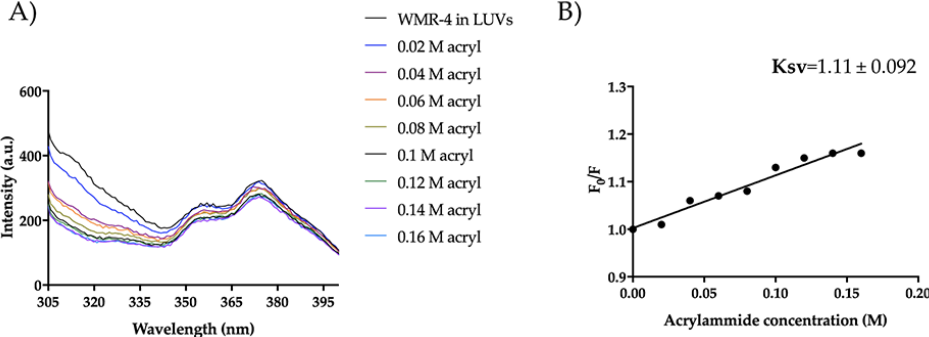
Figure 13. Trp fluorescence spectra for the peptide WMR-4 in LUVs of PE/PC/PI/Erg ( A ) and K sv quenching constant ( B ).